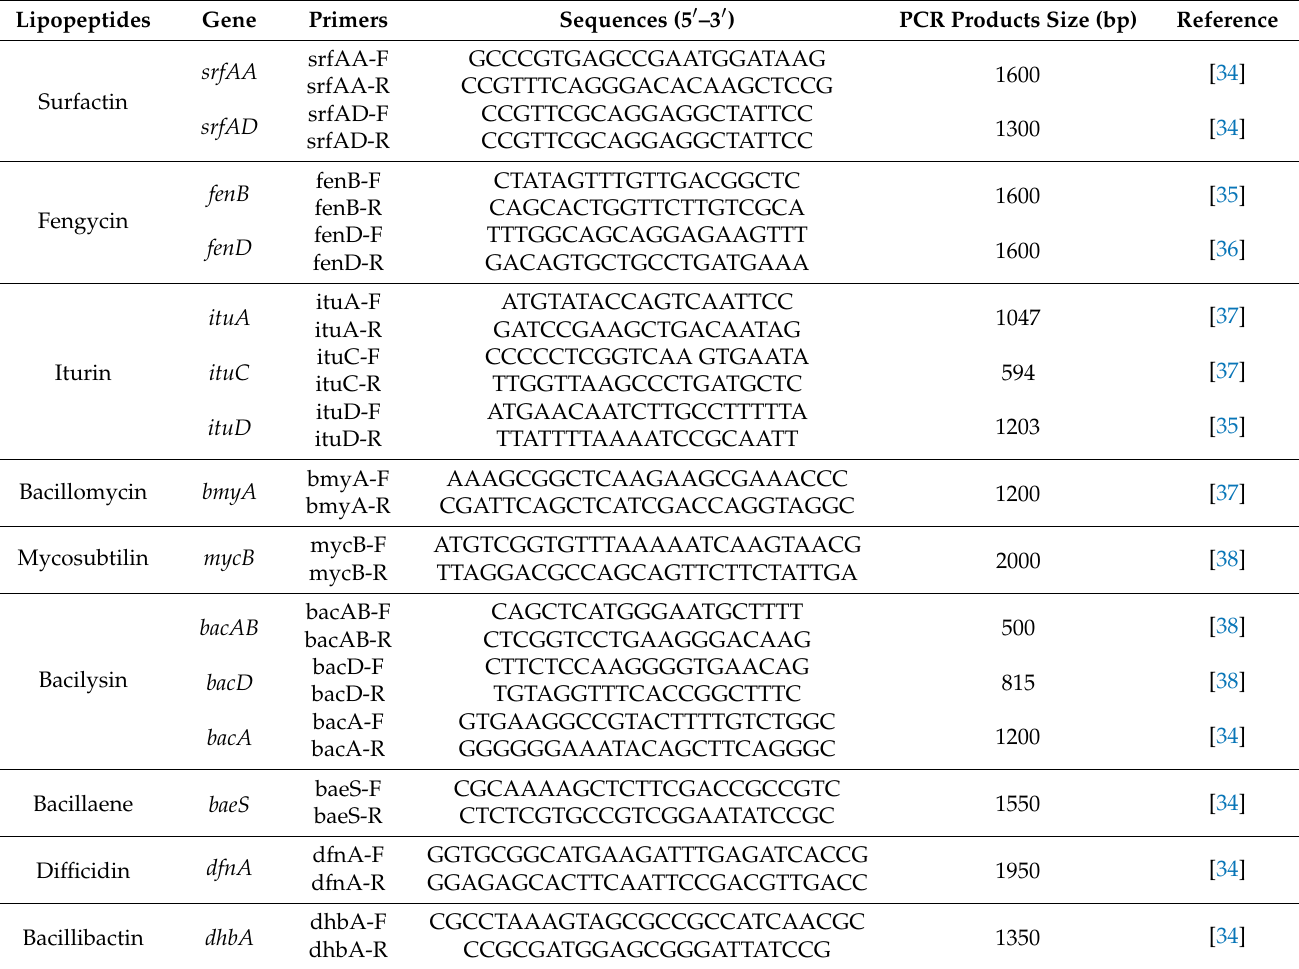
Table 1. Primers for gene amplification related to antifungal substances in strain